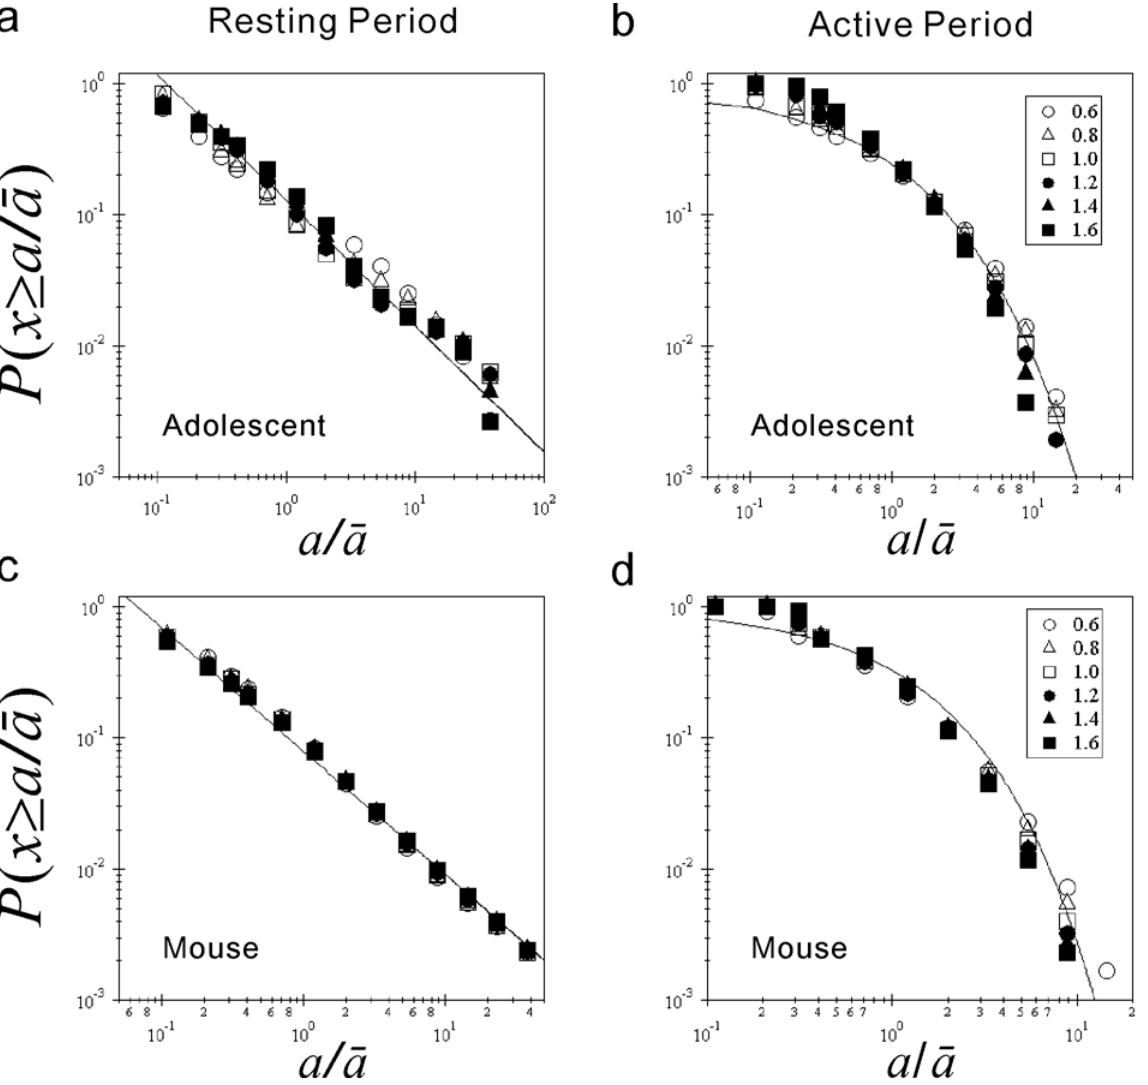
Figure 3. Invariance of the results with different threshold values. ( a and b ) Dependency of rescaled cumulative distribution on the threshold used to determine both resting and active periods in adolescents. ( a ) Rescaled (by the mean resting durations) cumulative distributions P x § a = a ð Þ of resting period durations a = a , where a is the individual mean of the resting period durations, with different threshold values of 0.6, 0.8, 1.0, 1.2, 1.4, and 1.6 times the overall average for non-zero activity counts. ( b ) The same as ( a ), but for active period durations. ( c and d ) The same as ( a ), ( b ), but for wild-type mice. The straight lines in ( a ) and ( c ) are eye-guides with the mean scaling exponent from a = a ~ 0 : 2 to 20 as the slope, with the threshold value of 1.0 ( c ~ 0 : 96 in ( a ) and c ~ 0 : 93 in ( c )). The curves shown in ( b ) and ( d ) are stretched exponential functions P ( x $ a )=exp( 2 a a b ) with the mean a ~ 1 : 43 and b ~ 0 : 54 in ( b ) and a ~ 1 : 46 and b ~ 0 : 59 in ( d ), respectively.